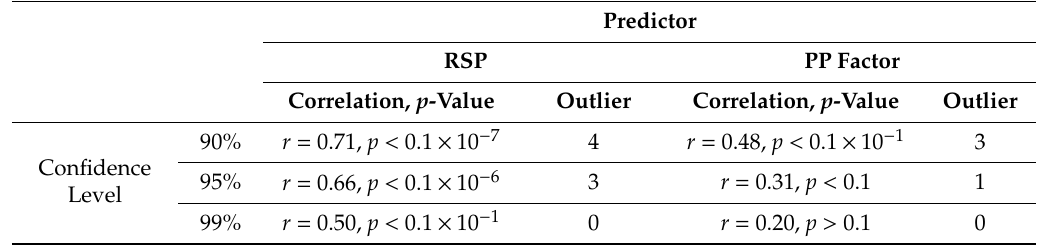
Table 2. Correlation analysis between resting state predictor (RSP) / performance factor (PP factor) and MI-BCI classification accuracy at various confidence